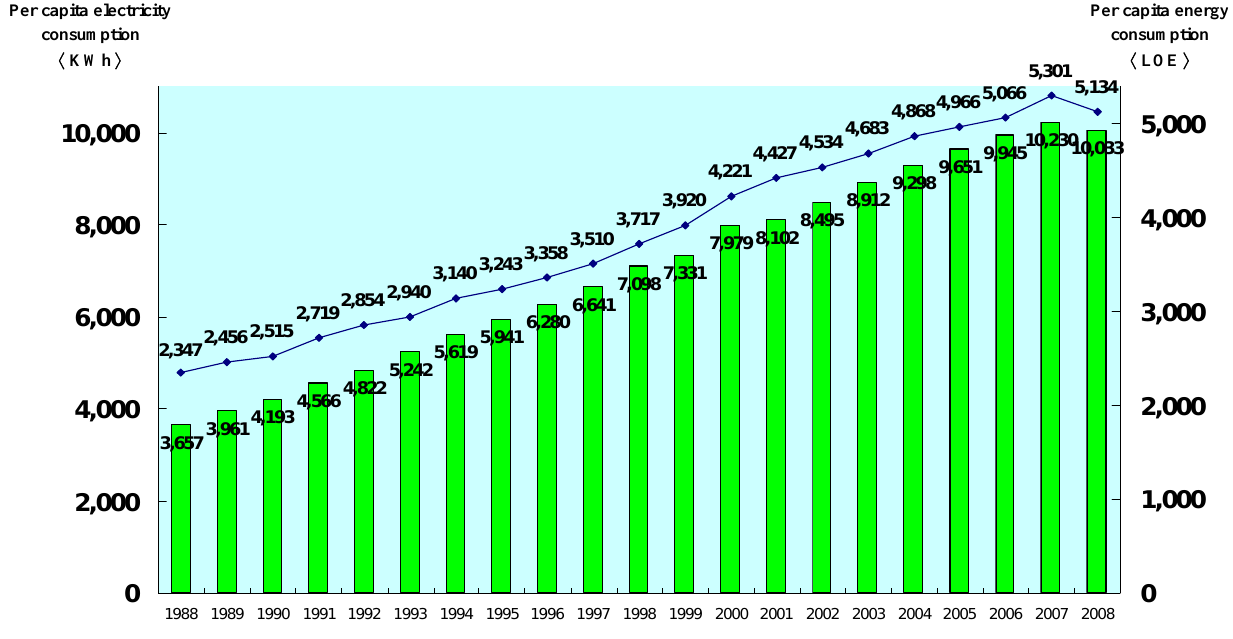
Figure 4. The structure of per capita energy consumption and electricity consumption